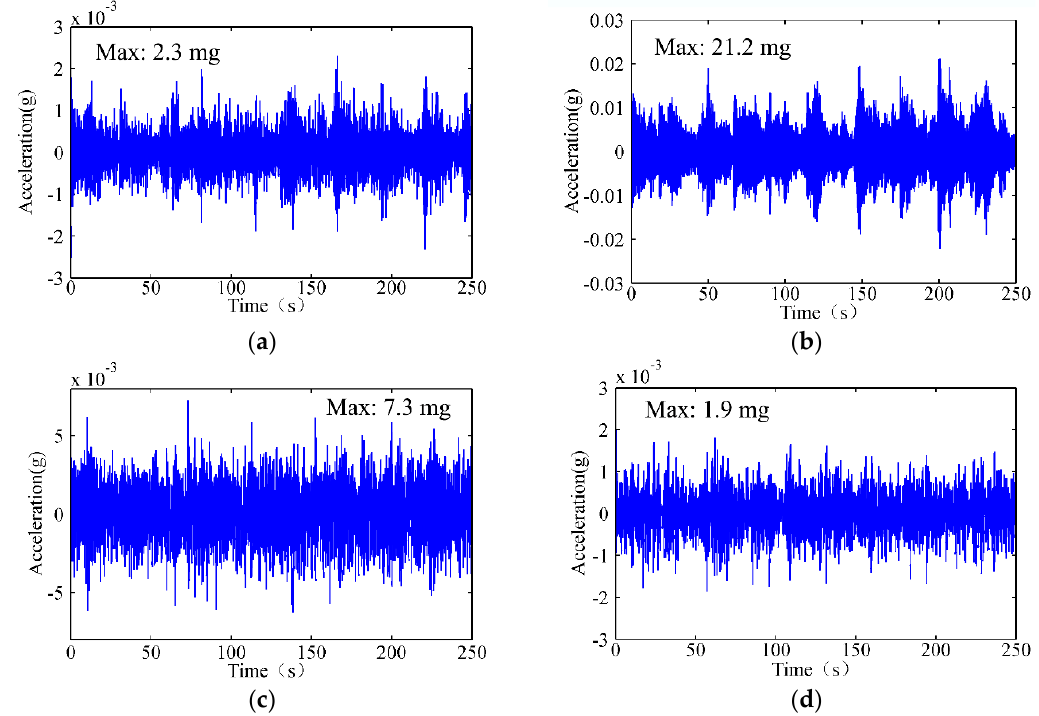
Figure 4. Acceleration responses of sensors: ( a ) Acceleration response of sensor 1; ( b ) Acceleration response of sensor 2; ( c ) Acceleration response of sensor 3; ( d ) Acceleration responses of sensor 4.